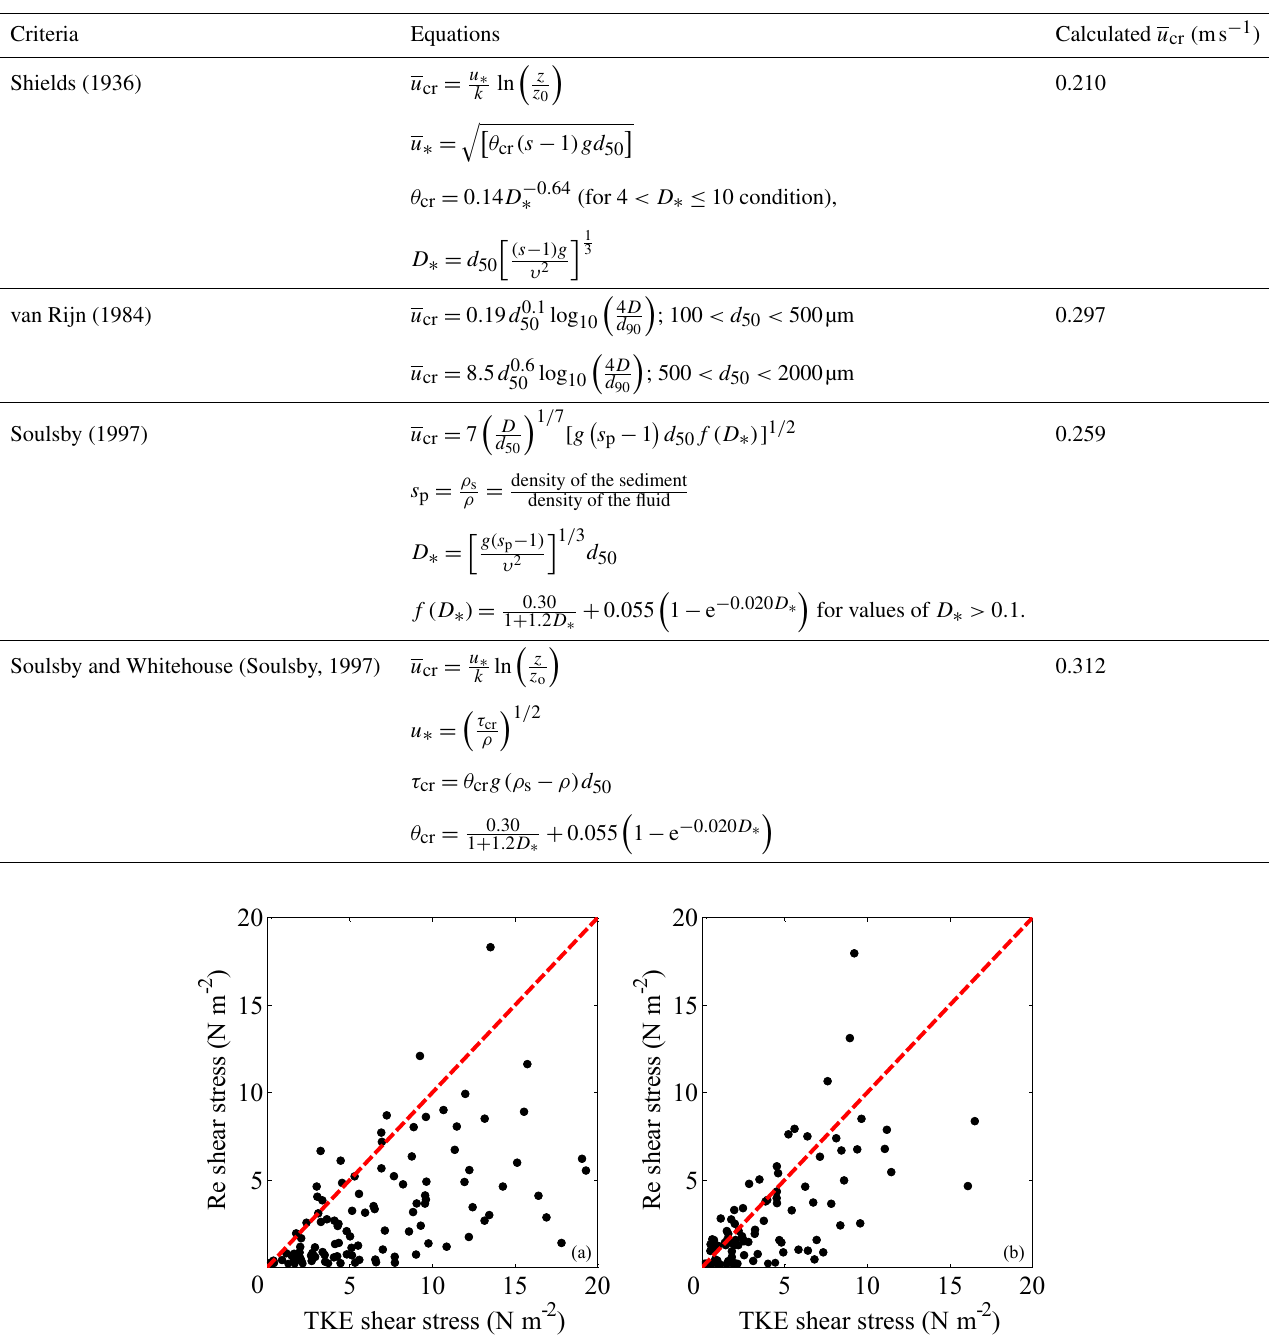
Figure 3. Comparison of the 1s mean Reynolds and TKE shear stresses from (a) above the measured mean critical velocity ( u > u cr,measured ) and (b) below the measured mean critical velocity ( u < u cr,measured ) experiments with a 2min period. The dashed red line defines the